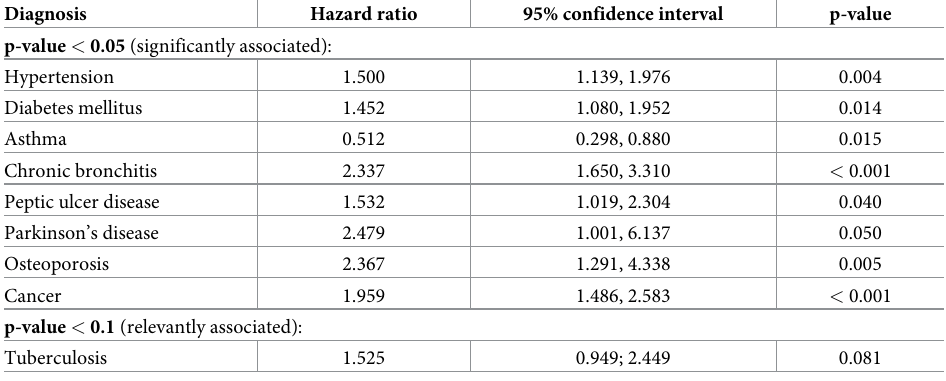
p-value < 0.1 (relevantly associated):